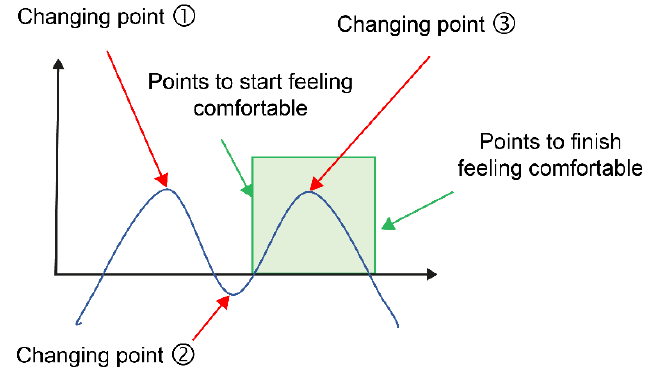
Figure 5. The meanings of the change points.